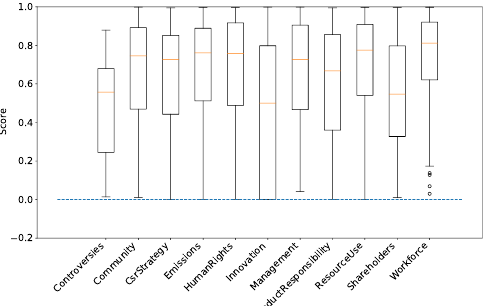
Figure 10. Distribution of data for lowest outliers of SHAP values of 2020 for Controversy